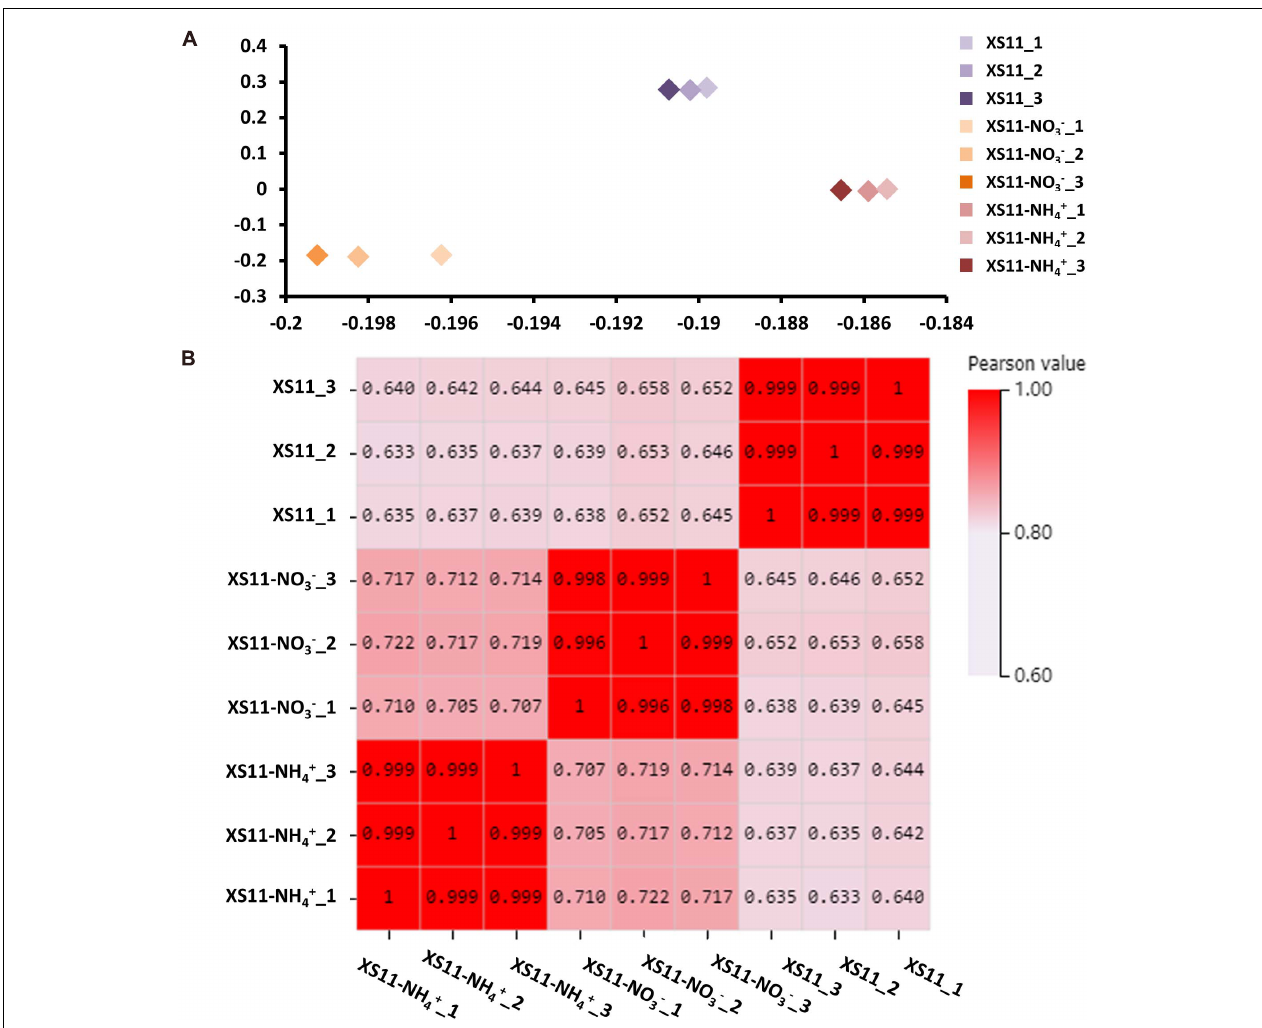
FIGURE 1 | Repeatability of RNA-seq expression profiles in biological replicates in Verticillium dahliae in response to two different nitrogen sources. (A) Principle component analysis (PCA) of expression data about samples with or without treatments including 10 mM nitrate (NO 3 − ) or 10 mM ammonium (NH 4 + ) with three biological replicates. (B) Pearson’s correlation values ( P < 0.01) non-clustering heatmap of nine samples displaying the correlation coefficient ( R 2 ).